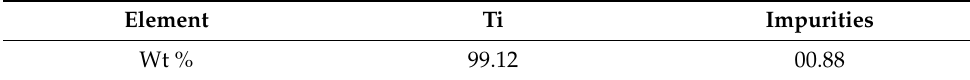
Table 2. Chemical composition of the pure titanium femoral implant. Element